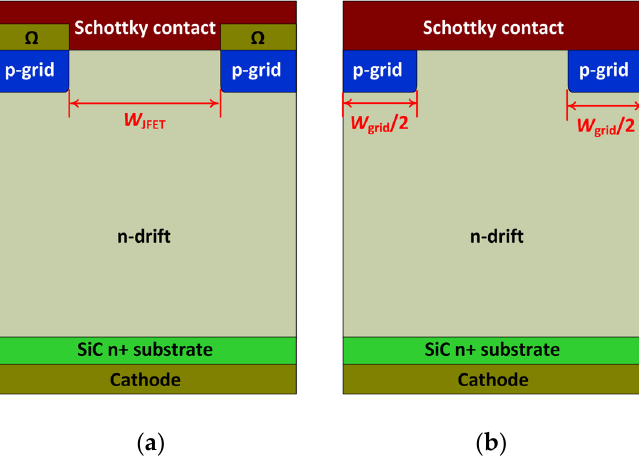
Figure 1. Schematic structures of ( a ) the SiC junction barrier Schottky (JBS) diode with Ohmic contacts to the p-grids and ( b ) the SiC JBS diode with Schottky contacts to the p-grids.